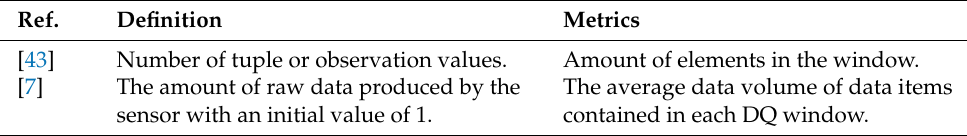
Table 4. Definition and metric of data